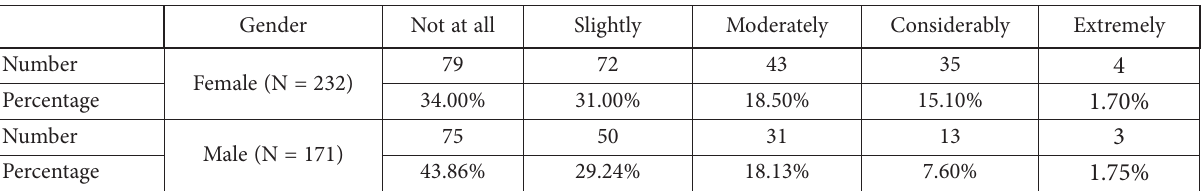
Table 6. The likelihood of striped buildings to cause headaches as indicated by the male and female participants Gender Not at all Slightly Moderately Considerably